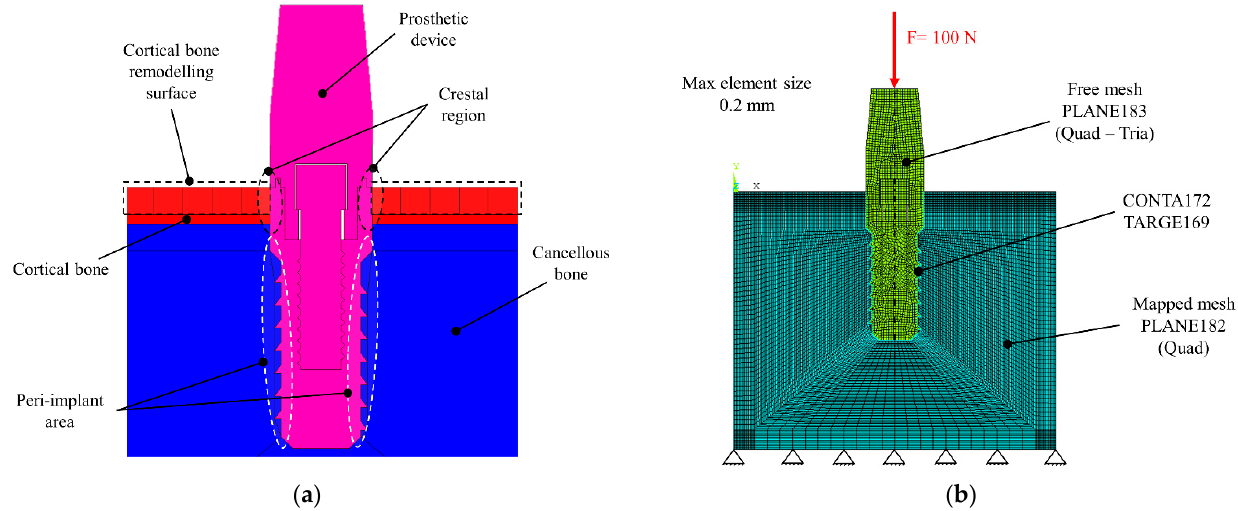
Figure 2. Finite element model: ( a ) Geometric discretization of the prosthesis–bone system; ( b ) Mesh and boundary conditions of the FE model.